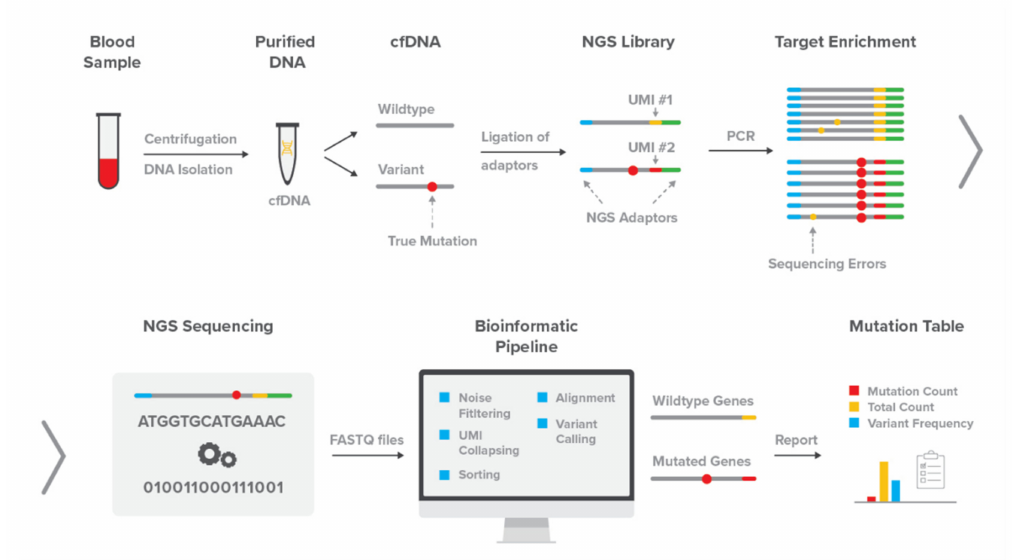
Figure 1. Overview of the DEEPGEN TM assay workflow. Blood samples from liquid biopsies or reference materials are used to isolate cell-free DNA (cfDNA). Unique molecular identifiers (UMI) are ligated to individual cfDNA strands, followed by an enrichment of cancer-relevant sequences using a customized primer panel. The enriched NGS libraries are subsequently sequenced on a Illumina NovaSeq 6000 and analyzed with the DEEPGEN TM bioinformatics pipeline. The output is a mutation table that contains the variant frequency for all targeted